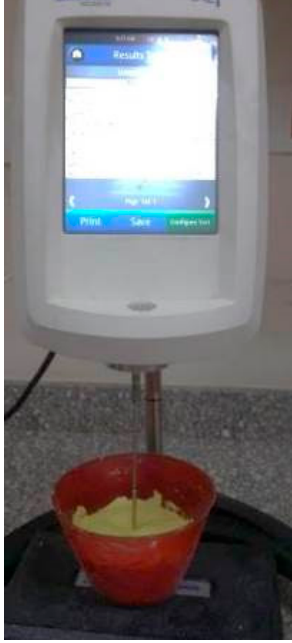
Figure 1. Spindle viscometer .